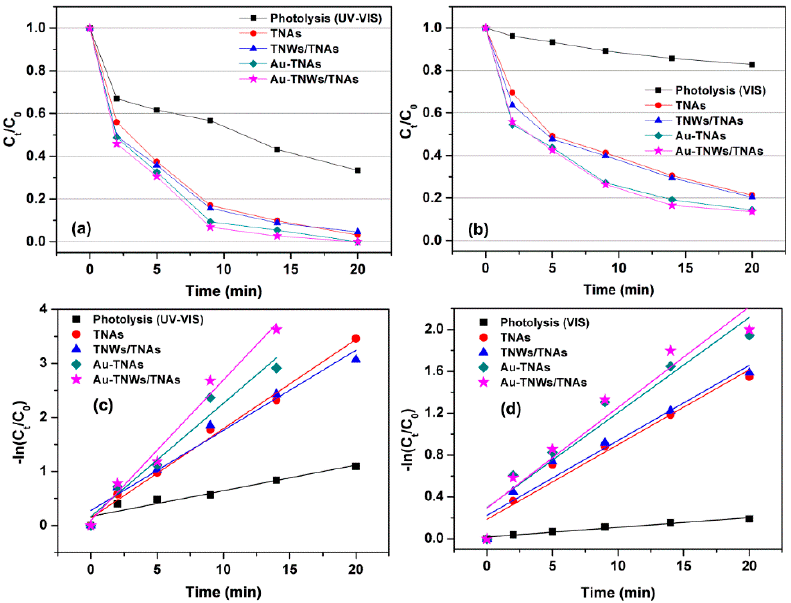
Figure 4. ( a ) Photocatalytic degradation of lincomycin (LCM, 500 ng / mL) using five reaction conditions of photolysis (UV-VIS), and photocatalysis (with TNAs, TNWs / TNAs, Au-TNAs, and Au-TNWs / TNAs). ( b ) Photocatalytic degradation of LCM under photolysis of the visible light ( λ ≥ 400 nm of Xenon lamp) and the photocatalysis conditions. ( c , d ) LCM degradation kinetic curves of the five reaction conditions under UV-VIS illumination ( c ) and VIS illumination ( d